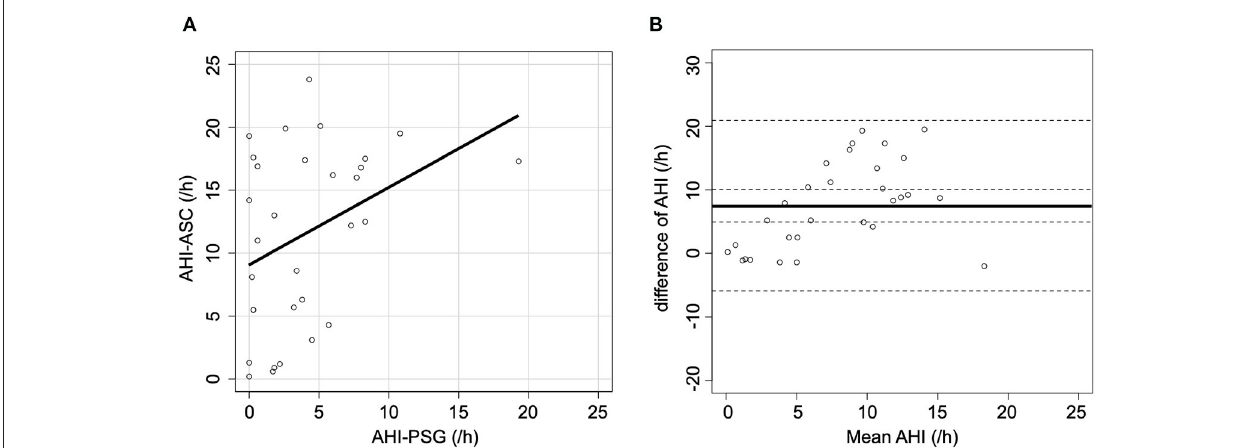
FIGURE 1 | Scatter and Bland-Altman plots comparing AHI-PSG and AHI-ASC. (A) There was a modest correlation between AHI-PSG and AHI-ASC. (B) The Y-axis indicates the difference between AHI-PSG and AHI-ASC [(AHI-PSG)–(AHI-ASC)]. The X-axis indicates the mean values of AHI. The solid line represents the mean difference, while the dashed lines represent the limit of agreement ( ± 2 SD).